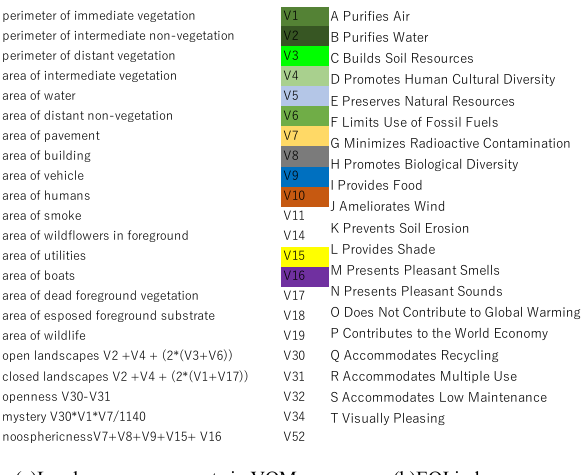
Figure 2 . Indicators in VQM